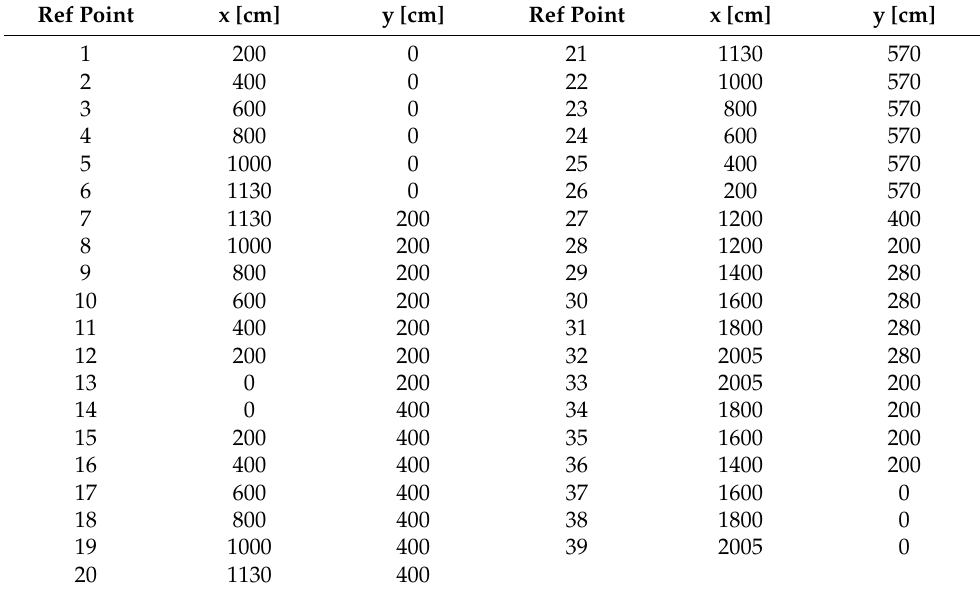
Table 2. Coordinates of the reference points (tag